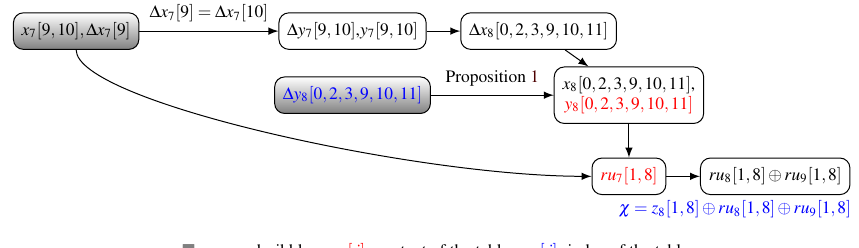
Figure 9: Constructions of Table T 0 each index in average.